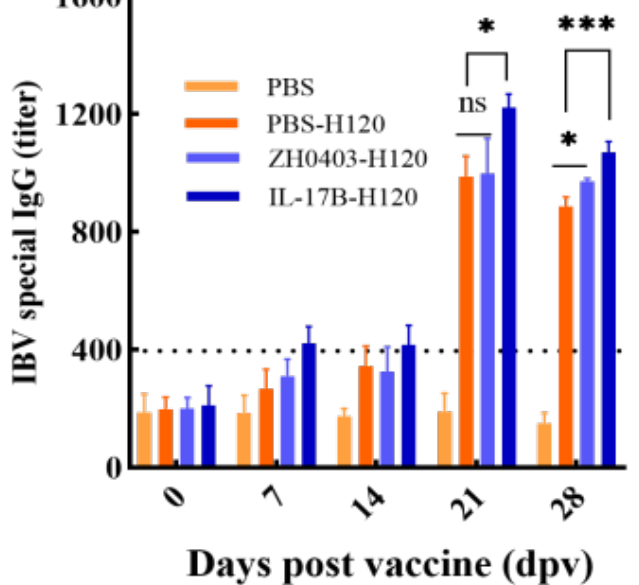
Figure 9. IBV-specific antibodies in the serum detected using ELISA. The IBV-specific antibody levels were measured at 0th, 7th, 14th, 21st, 28th dpv before IBV infection. Values above 396.39 are considered positive. The statistical analysis was performed via one-way ANOVA test. *: p < 0.05, ***: p < 0.001.